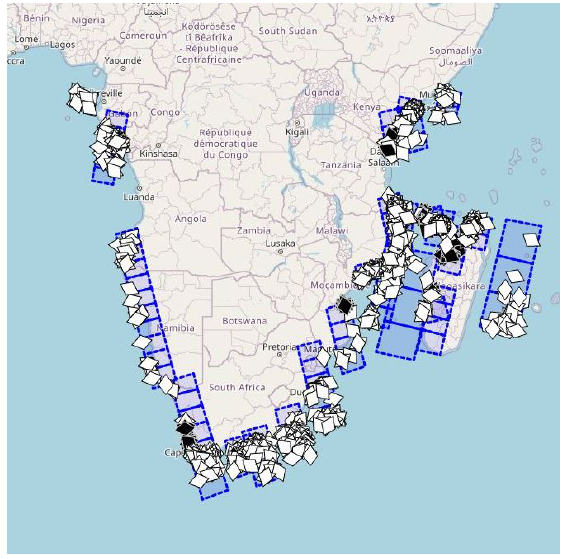
Figure 4. OCIMS Integrated Vessel Tracking System showing Vessels Detected from using only SAR Sentinel-l and Radarsat-2 (Note: Radarsat-2 data only covers SA